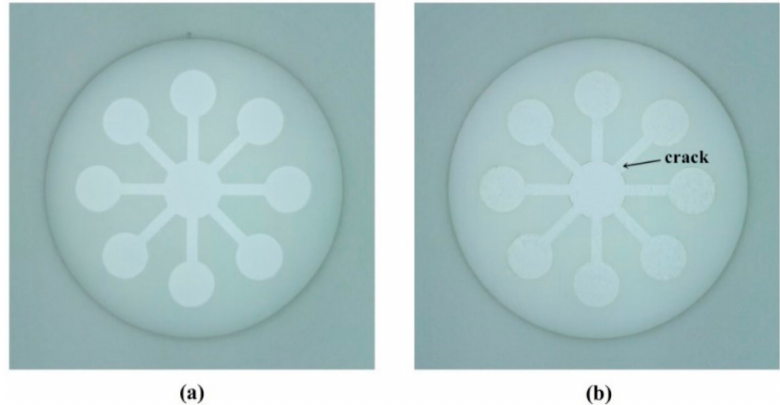
Figure 7. The chips filled with cellulose powder ( a ) and cellulose suspension ( b ) after 24